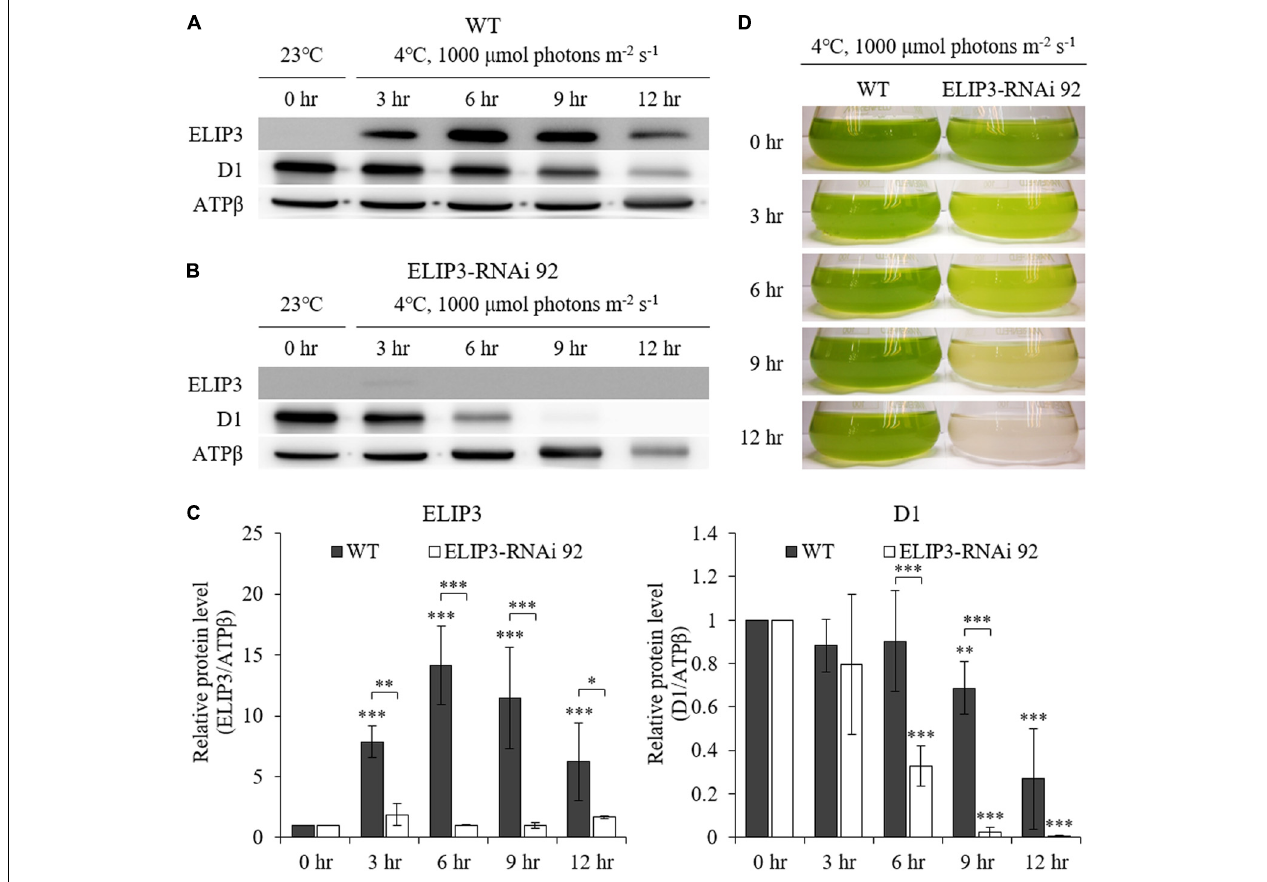
FIGURE 7 | Characterization of ELIP3 knockdown strain RNAi 92 at low temperature (4 ◦ C) and high light (1,000 µ mol photons m − 2 s − 1 ) conditions. (A) Western blot analysis of ELIP3 and D1 in WT and (B) RNAi 92. ATP β was used as a loading control. (C) Densitometry of western blots in (A,B) . Data are expressed as mean ± SD (two-way ANOVA with Bonferroni’s multiple comparisons test, n = 3). (D) The response of WT and RNAi 92 strain to low temperature and high light in static culture condition. ∗ P < 0.05, ∗∗ P < 0.01, ∗∗∗ P <